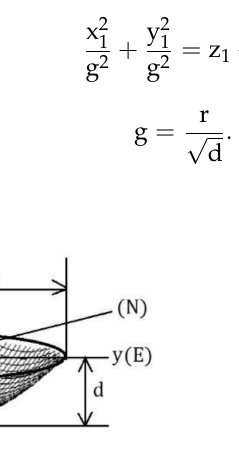
Figure 4. Rotating paraboloid basin model for Ao-ike